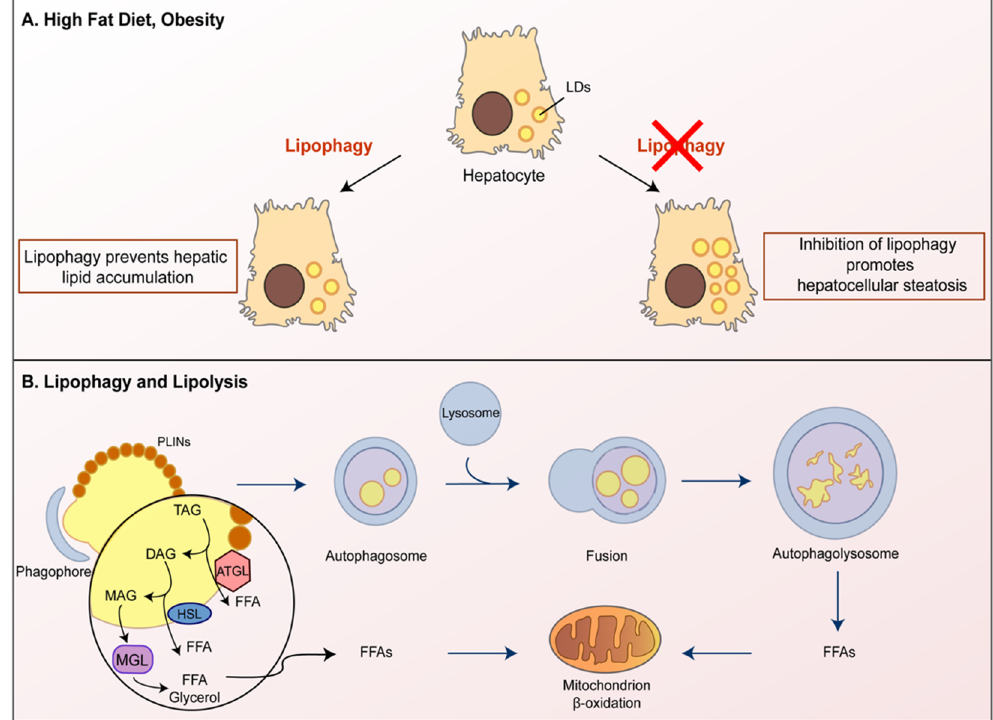
Figure 3. The autophagy involvement in lipid droplets turnover. Autophagy plays a key role in lipid droplets (LDs) metabolism in hepatocytes. ( A ) Autophagy breaks LDs inside lysosomes in a process termed lipophagy. Lipophagy can prevent lipid accumulation in hepatocytes, while the inhibition of lipophagy promotes LDs accumulation, resulting in hepatocellular steatosis. ( B ) Lipolysis is a process mediated by three lipases: ATGL, HSL and MGL. ATGL controls the crosstalk between lipolysis and autophagy as it regulates TAG turnover. ATGL promotes lipophagy to facilitate LD catabolism leading to the generation of Free Fatty Acids (FFAs), which are broken down by the β-oxidation process.